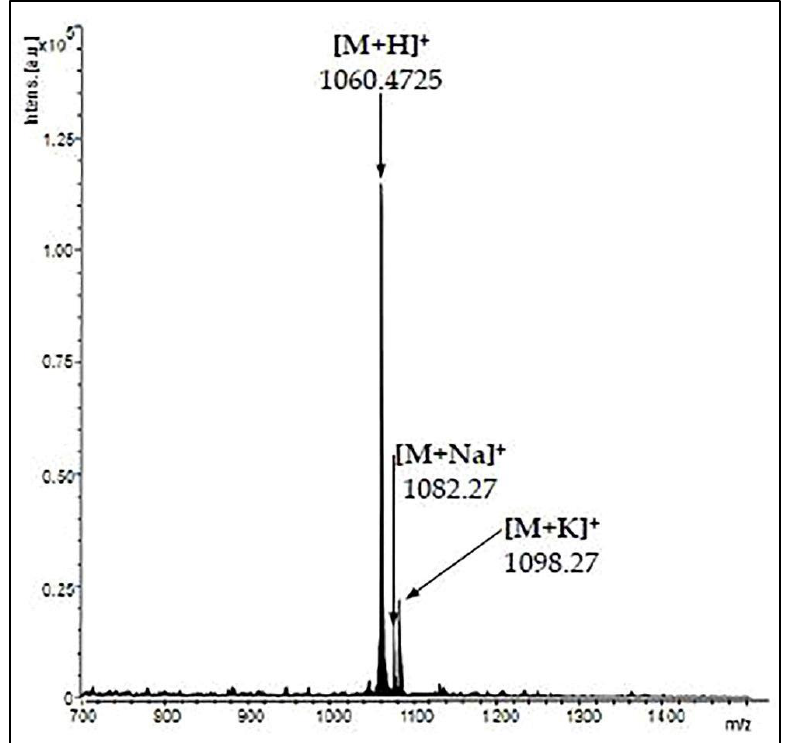
Figure 1. Matrix Assisted Laser Desorption/Ionization—Time of Flight (MALDI-TOF) mass spectrum of Aβ 25–35 peptide.